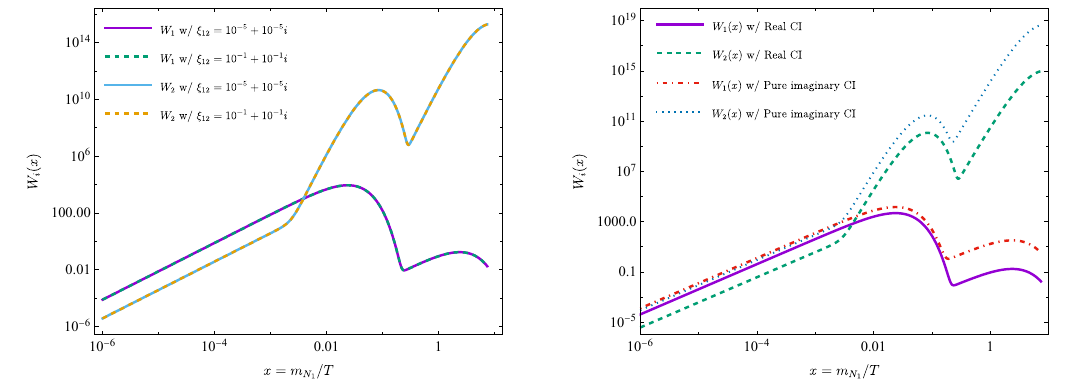
Figure 10 . The time evolution of the washout functions W 1 , 2 [(C.16) and (C.21)]. (Left) The ξ dependence of W with the real CI parameters (4.18). (Right) The Yukawa coupling dependence 1 , 2 of W 1 , 2